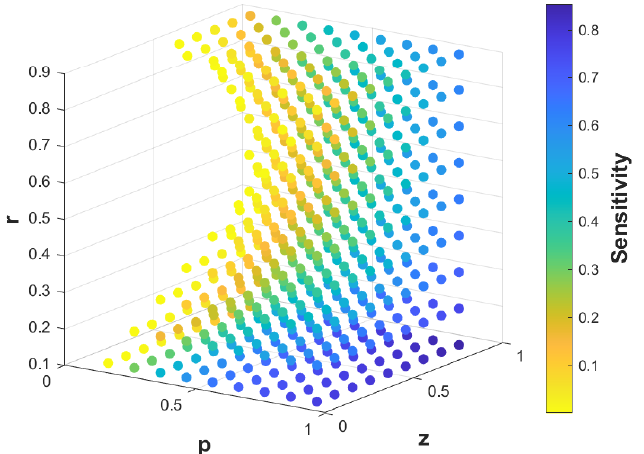
Figure 7. Sensitivity with different r , z , and p . The three coordinates represent r , z , and p , respec- tively. Sensitivity is represented by different colors. The deeper the color, the higher the sensitivity . The vacant parts indicate that the sensitivity is zero when r , z , p take the corresponding